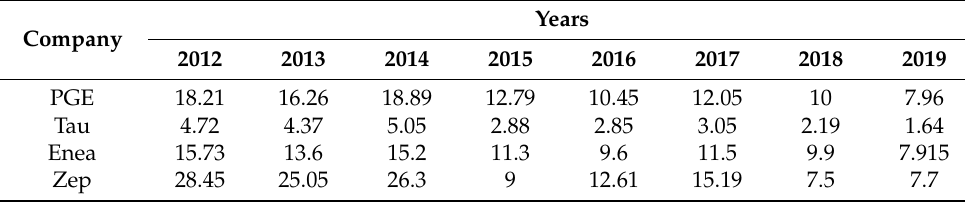
Table 5. Quotation level of companies at the end of the year (in PLN) (as at the end of the year).